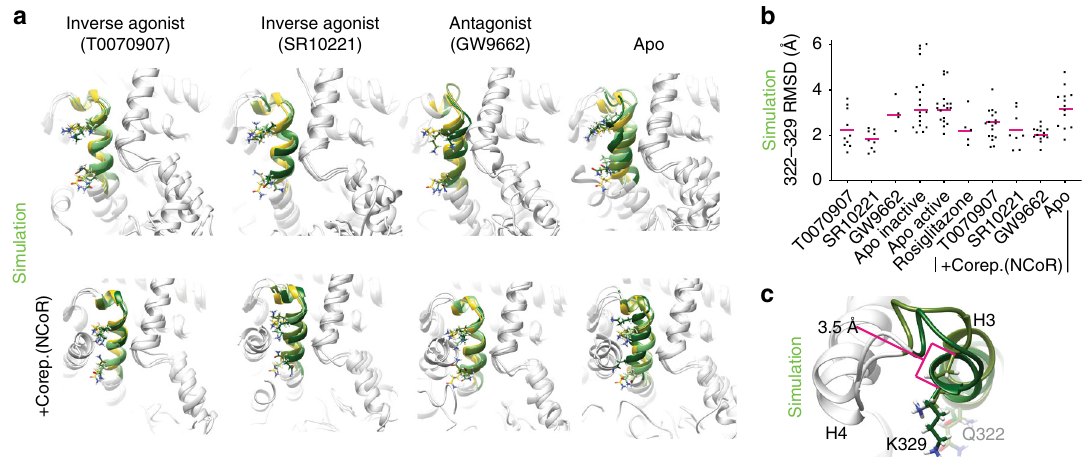
Fig. 5 Simulations indicate that the apo helix 3 charge clamp is dynamic and is stabilized upon ligand binding. a The c-terminal portion of helix 3 is highlighted in color. The side chains of the charge clamp (K329) and the BTFA probe location (Q322) are shown. Dark green, olive drab, and light green indicate that the structures are a representative structure from the three lowest energy wells in the aMD energy landscape for the indicated PPAR γ -ligand or PPAR γ /ligand/NCoR complexes. A representative structure from the only well in the rosiglitazone PPAR γ simulation is shown in yellow for reference. b RMSD of residues 322 – 329 of individual cMD simulations that were started from representative structures from the lowest energy wells for the indicated complexes compared to the same residues in the crystal structure 1PRG (apo PPAR γ ). Boltzmann averages are shown as magenta bars. c Comparison of representative structures from the lowest (dark green) and second lowest (olive drab) energy wells of inactive apo PPAR γ . The distance between the alpha carbon atoms for the charge clamp residue K329 for the two structures is indicated. Source data are provided as a Source Data fi le (Source data_Heidari.xlsx).